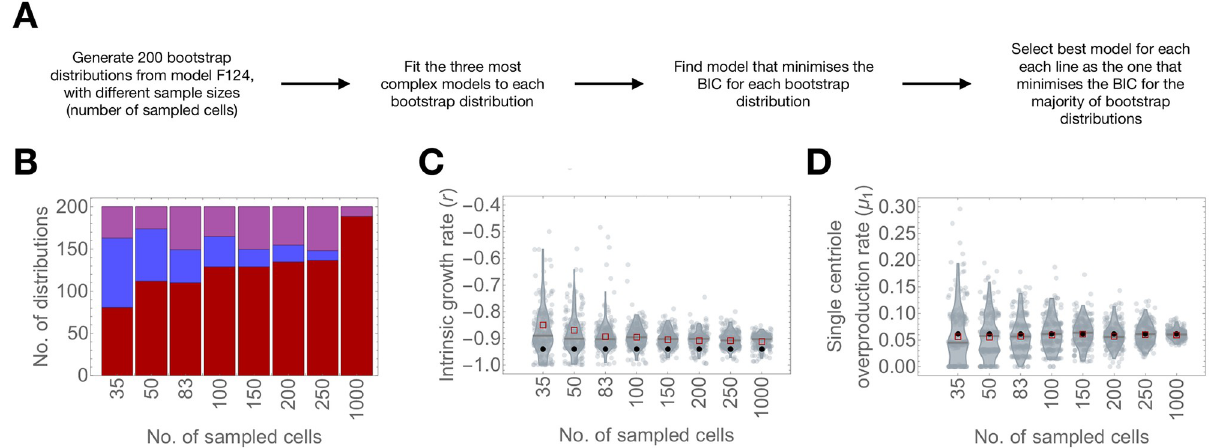
Fig 6. Accuracy and precision of the inference method increase non-linearly with the number of sampled cells. A—Number of bootstrap distributions for which model F124 (red), L124 (blue), and E124 (purple) fitness functions were selected as the best in simulations of model F124 as a function of bootstrap sample size. Input parameter values for the simulations: r = − 0.940, μ 1 = 0.062, μ 2 = 0.096, μ 4 = 0.288. B-C—Bootstrap distribution of parameter estimates for intrinsic growth rate r (B) and single-step overproduction rate μ 1 (C) as a function of bootstrap sample size. Black dots indicate the median estimated value and the green dot indicates the input value used in the